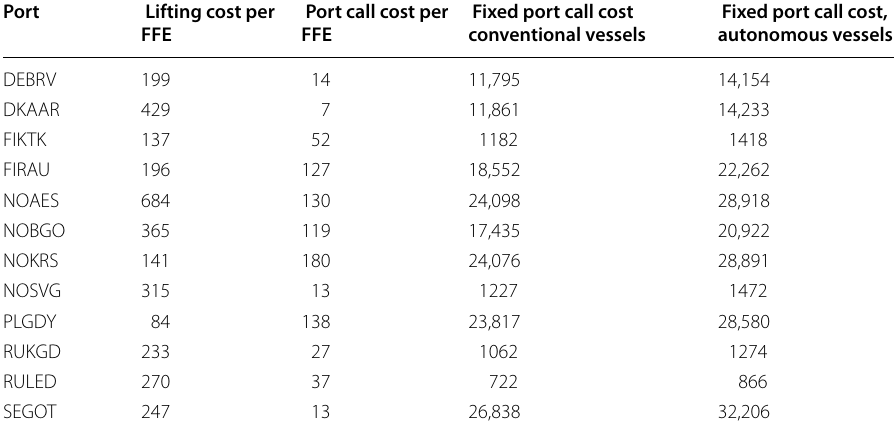
Table 1 Operating costs at the different ports (in USD) Port Lifting cost per Port call cost per Fixed port call cost FFE FFE conventional vessels